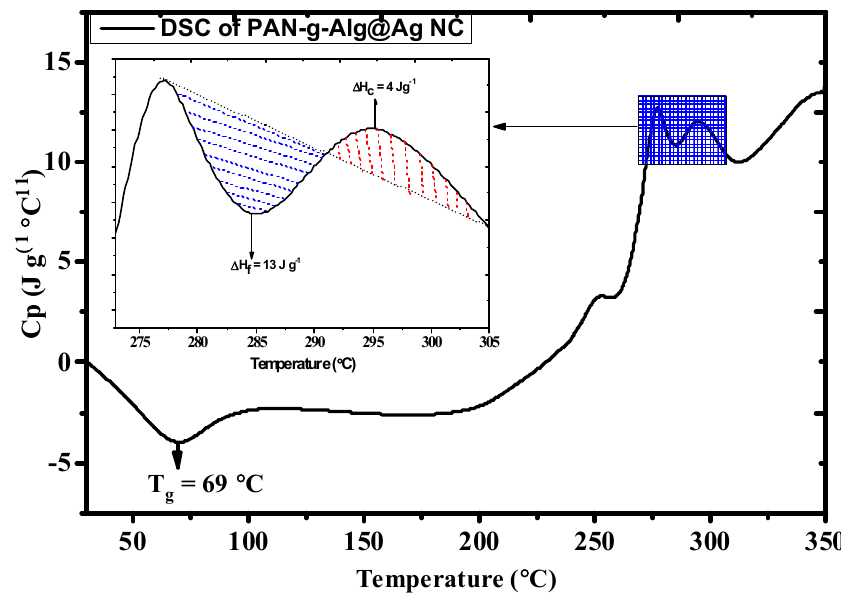
Figure 6. DSC spectrum of the PAN-g-Alg@Ag NCs.